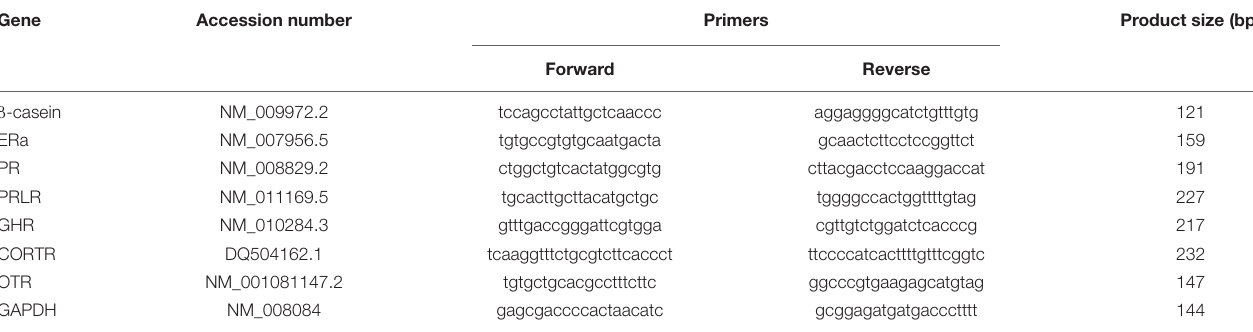
TABLE 2 | Primer sequences for real-time PCR in mouse mammary